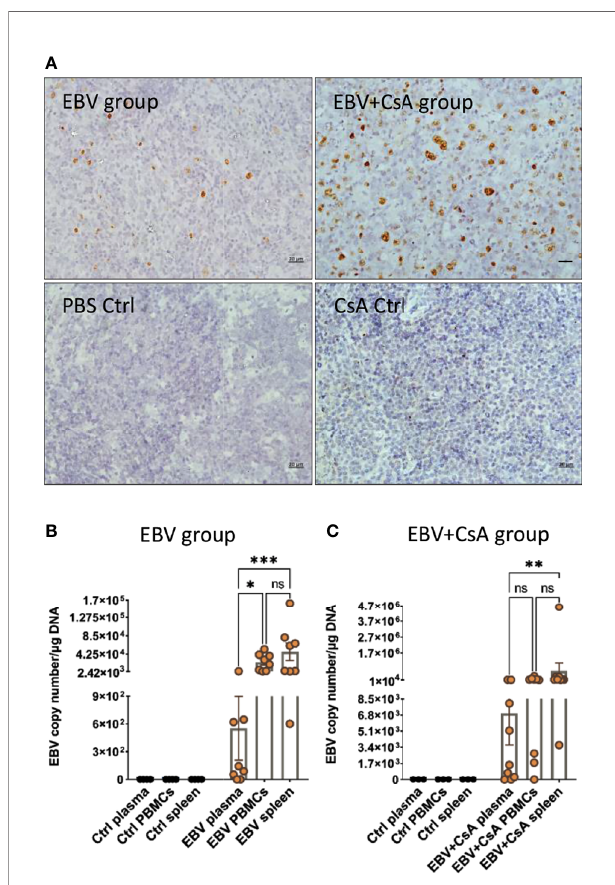
FIGURE 1 | EBV inoculated rabbits exhibit viremia and high viral DNA load in the periphery. (A) Representative images of EBER-ISH on rabbit spleen from EBV and EBV+CsA group and their corresponding controls. Scale bar=20µm. (B) EBV copy number measured using qPCR in plasma, PBMCs, and spleen of rabbits in EBV group ( n =8) and PBS controls ( n =4), and (C) EBV+CsA group ( n =9) and CsA controls ( n =3). Samples with undetermined EBV levels were plotted at y =0. EBV load is presented with mean ± SEM, and comparisons were made using the nonparametric Friedman test and Kruskal-Wallis. ns: p > 0.05, * p ≤ 0.05, ** p ≤ 0.01, *** p ≤